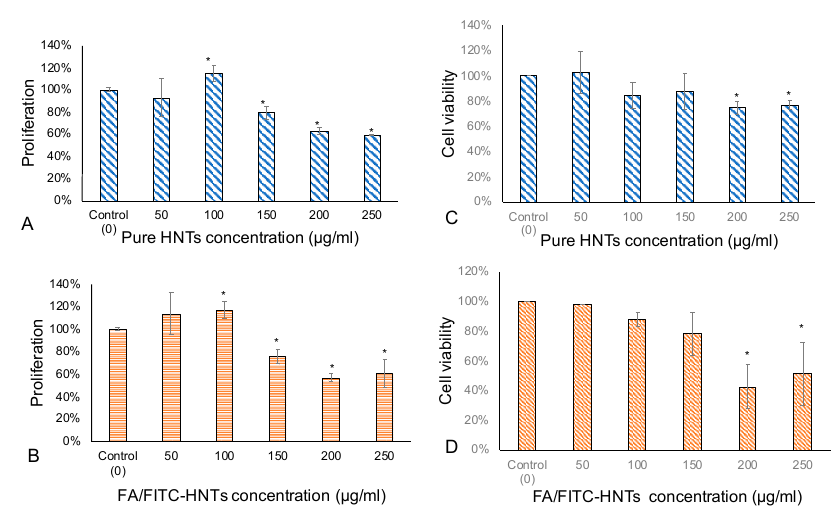
Figure 3. XTT Cell Proliferation Assay. CT26WT cells were cultured with pure HNTs ( A ) and bi-HNTs ( B ) at di ff erent concentrations. Cell proliferation at each di ff erent concentration was calculated with comparison to the control group. CT26WT cells cultured with pure HNTs ( C ) and bi-HNTs ( D ) at di ff erent concentrations. Cell viability at each di ff erent concentration point was calculated by comparison to the control group. (error bar with standard deviation, n = 6, * represents p < 0.05).